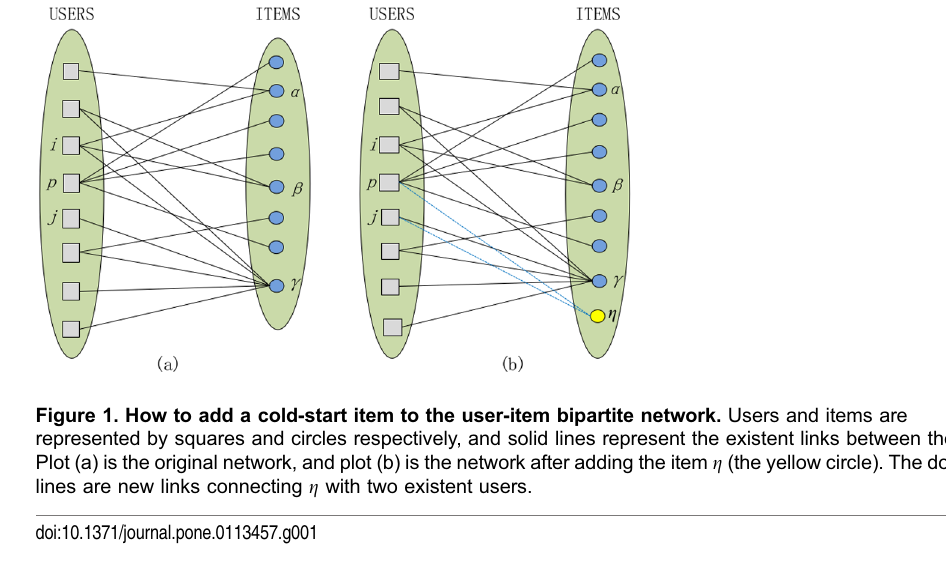
Table 1. Basic statistical properties of the two data sets. Data